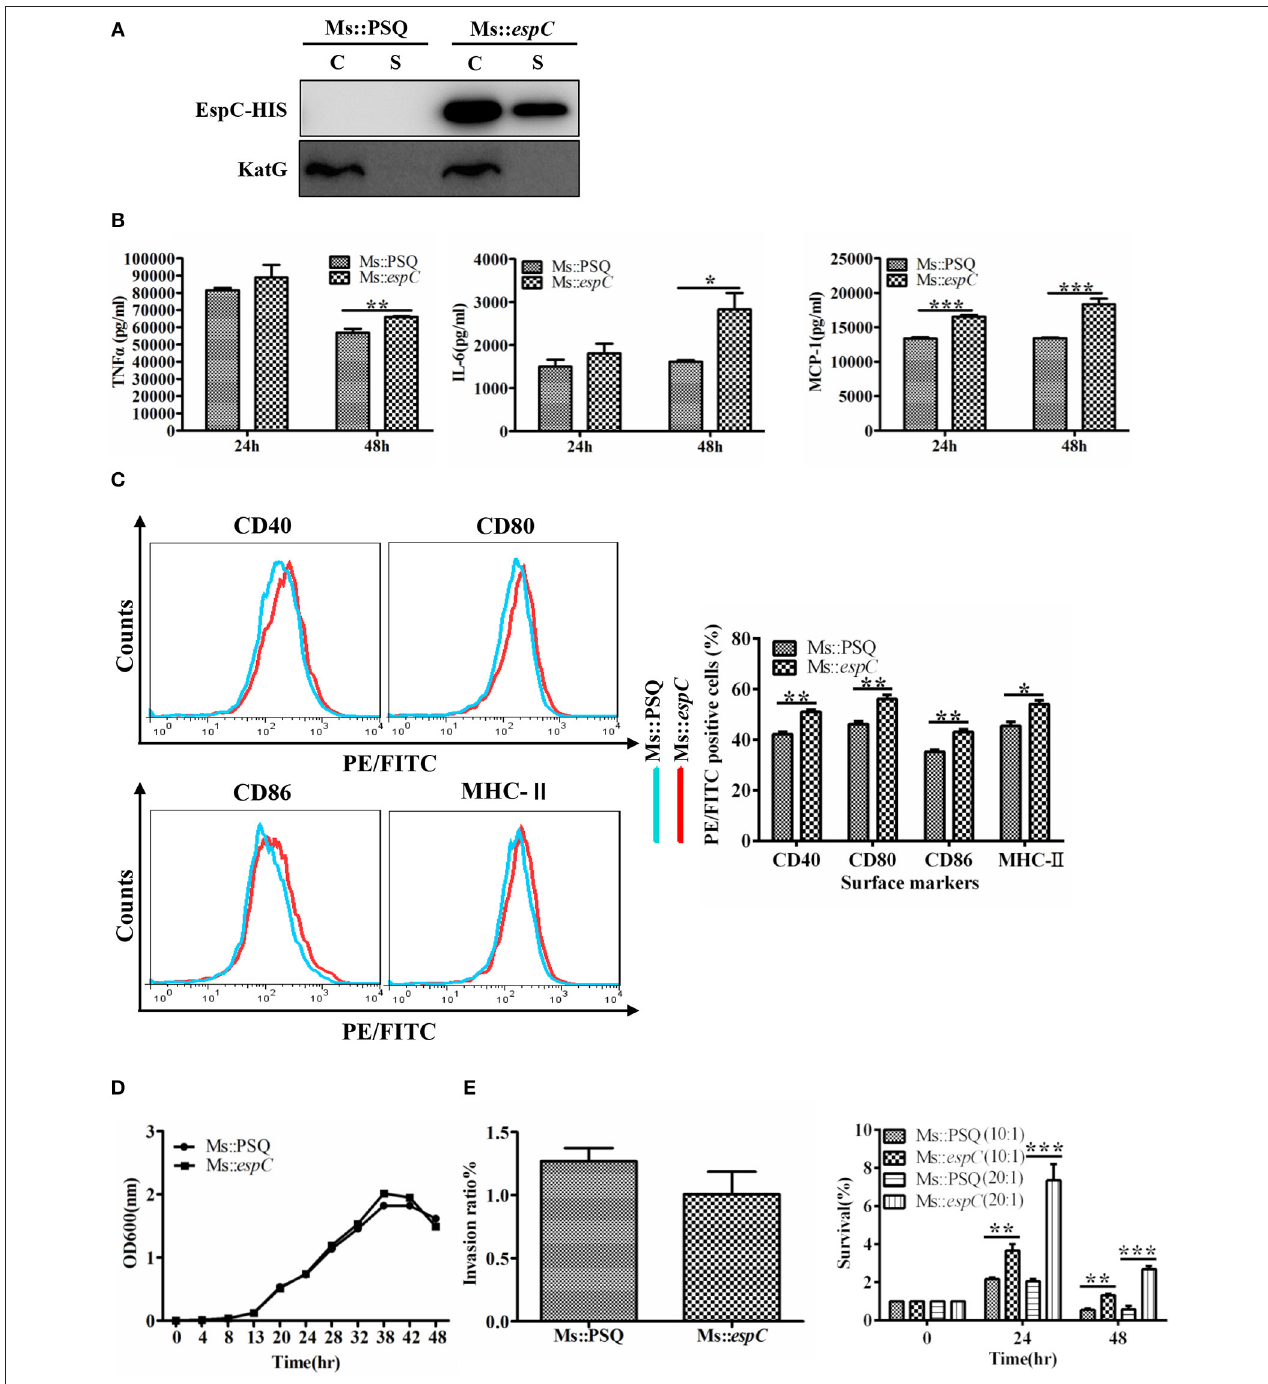
FIGURE 6 | EspC increased survival of M. smegmatis within macrophages. RAW264.7 cells were infected for 24 or 48h at an MOI of 10 with the indicated mycobacterial strains. (A) The two strains were cultured in Sauton containing 50 µ g/mL kanamycin for 3 days, and both the bacteria and cell culture supernatant were then harvested for western blot analysis using mouse anti-His monoclonal antibodies. C: supernatants of bacterial supersonic lysates; S: cell culture filtrates. (B) Amounts of TNF- α , IL-6, and MCP-1 present in the culture medium were measured by ELISA. (C) The expression of CD40, CD80, CD86, and MHC-II was analyzed by flow cytometry. (D) Bacterial growth of Ms:: espC and Ms::PSQ at 37 ◦ C in 7H9 broth supplemented with 10% OADC, as plotted using OD 600 values determined every 6h. (E) RAW264.7 cells were infected with Ms:: espC or Ms::PSQ on day 0 (4h after infection). We used an MOI of 10 for infection. Invasion ratios denote the ratio of the number of intracellular bacteria and the number of initial bacteria; RAW264.7 cells were infected with Ms:: espC and Ms::PSQ at an MOI of 10 or 20.